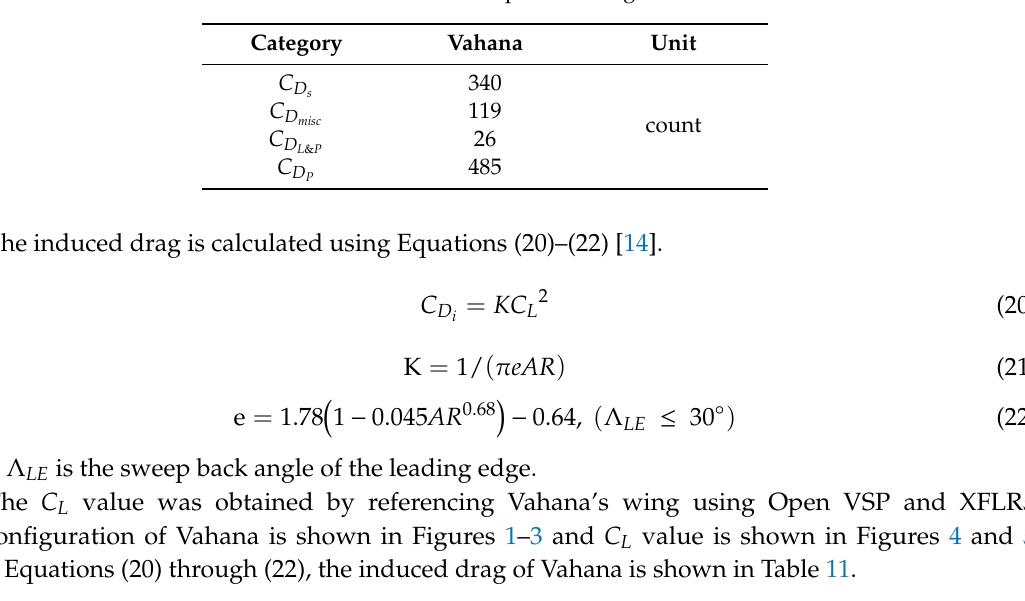
Table 9. Vahana wetted area.